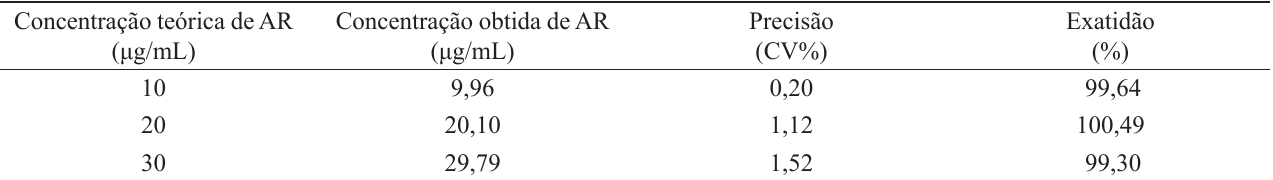
TABELA III - Valores obtidos na avaliação da precisão e exatidão